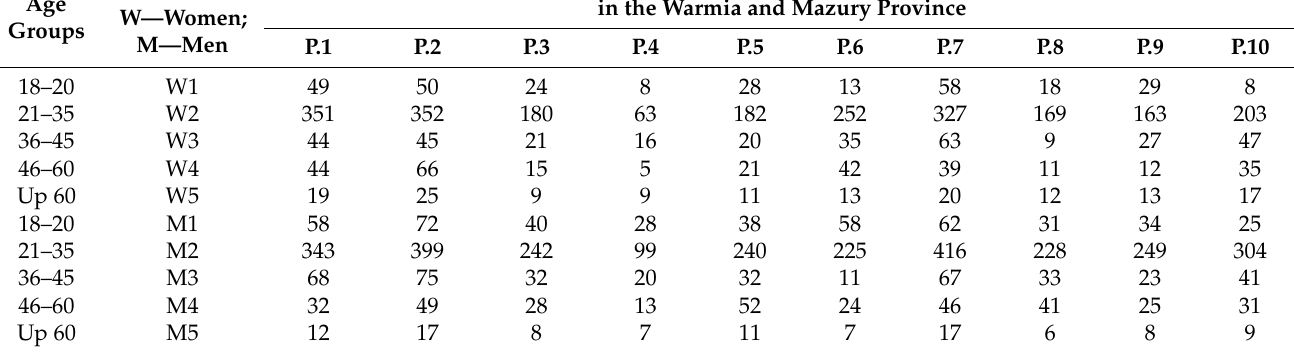
Table 2. Number of statistical features describing the prosumption according to sex and age groups of respondents. Age